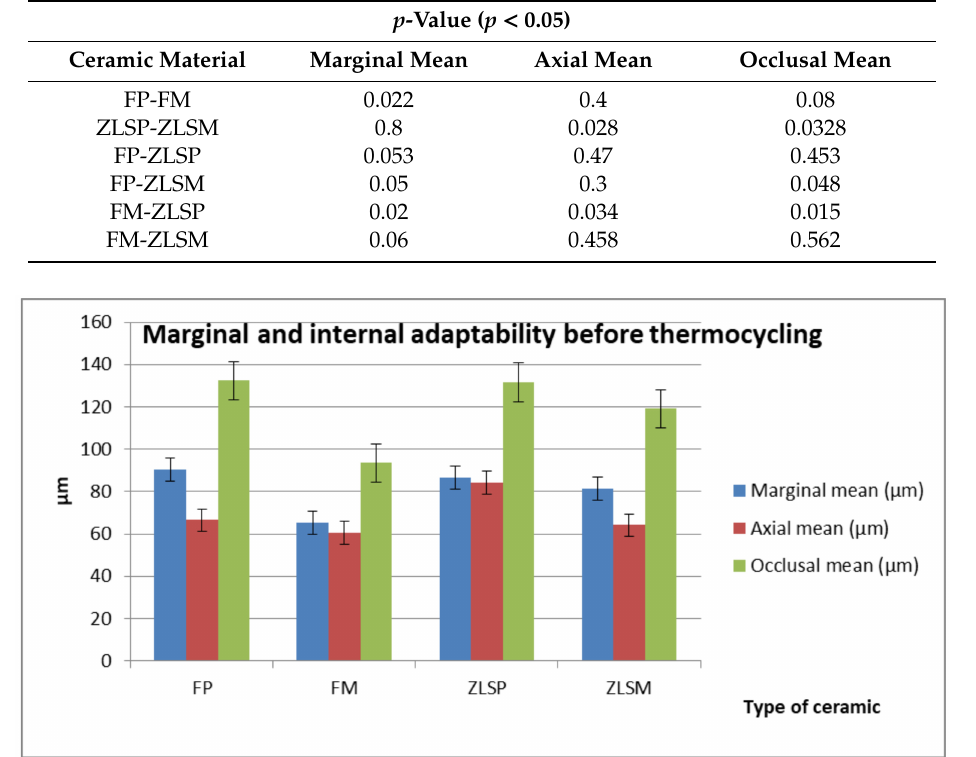
Figure 9. Mean values and standard deviation before cementing and thermocycling the ceramic